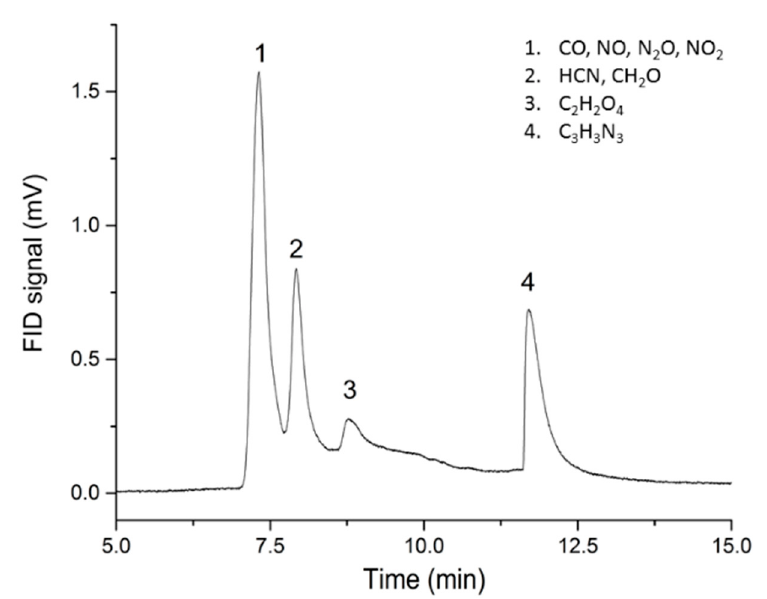
Figure 3. GC chromatograph for a probe temperature of 700 °C (85-15 propellant).